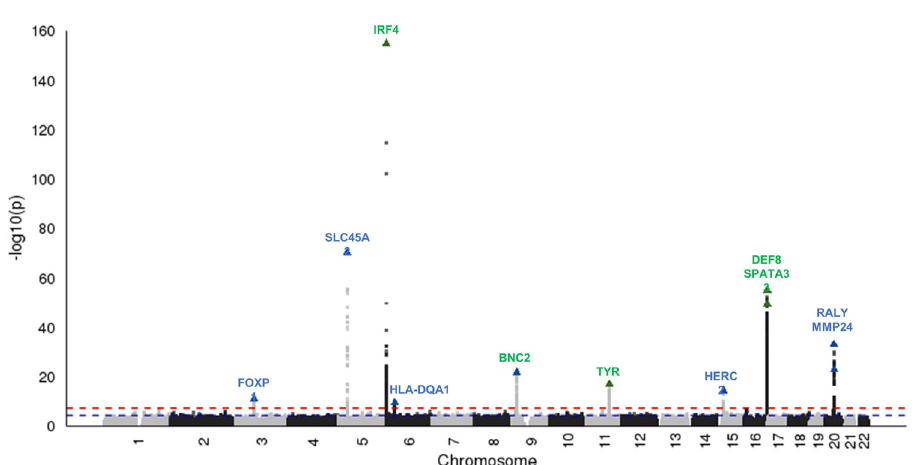
Fig. 1 Manhattan plot of GWAS of actinic keratosis of GERA discovery cohort ( n = 63,110). The y axis represents log-scale P -values, and loci with the smallest P obtained from the logistic regression are labeled with the nearest or corresponding gene ’ s name. Known loci are in green triangles and newly identi fi ed loci are in blue